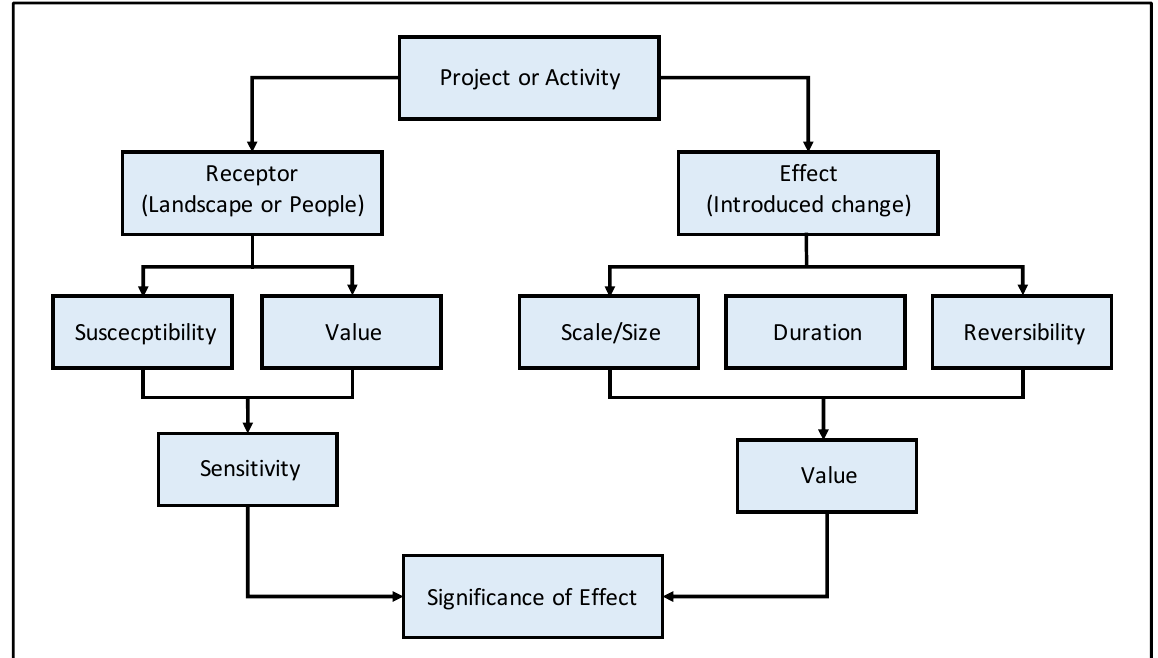
Figure 3. The GLVIA process for assessing the significance of effects. Adapted from [21]. The second step is to determine the magnitude of the change, which is based on the degree (i.e., size and scale), geographic extent, and duration and reversibility of the change. The degree might be changes to the composition or visual contrast in a